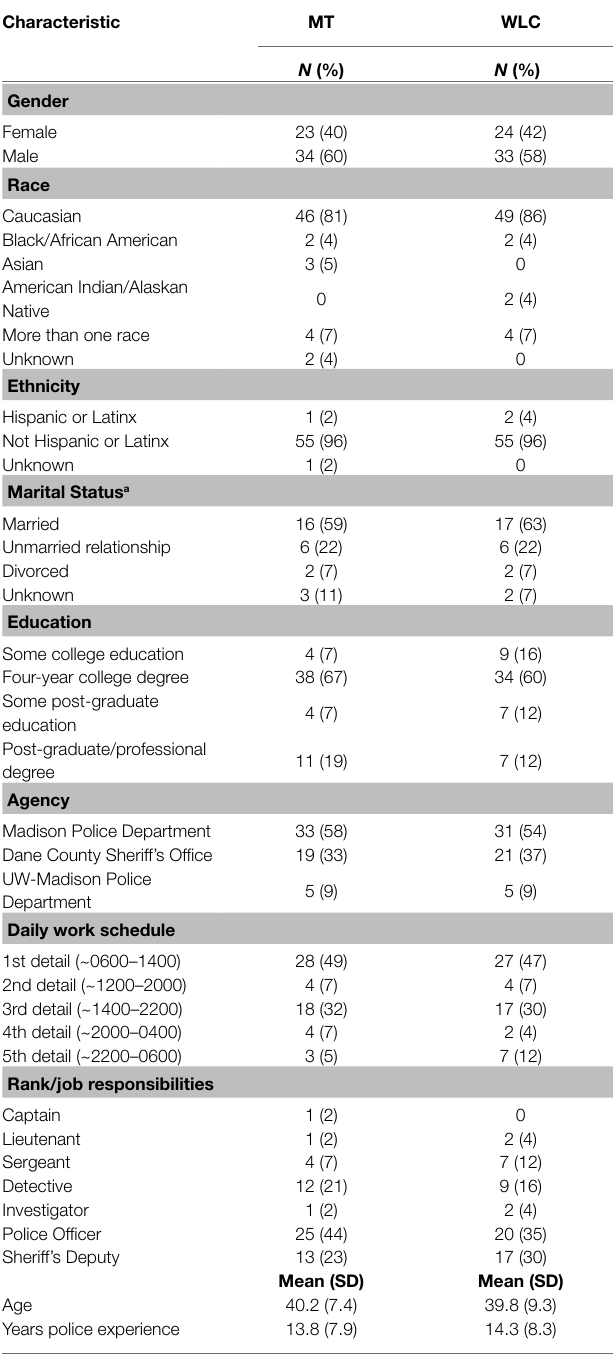
TABLE 1 | Demographic and work